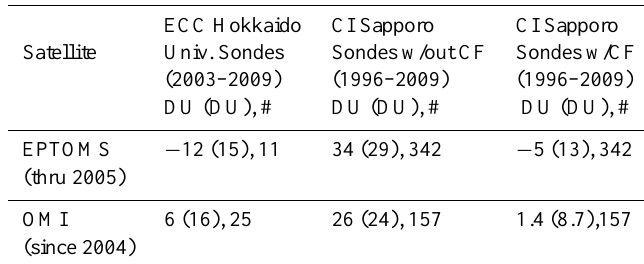
Table 9. Differences in column ozone amounts between ozonesondes and Earth Probe TOMS (EPTOMS) and Ozone Mapping Instrument (OMI). Data from electrochemical concentration cell (ECC) ozonesondes launched at Hokkaido University (which use the En-Sci two cell KI technology) and the Carbon Iodine (CI) ozonesondes launched at Sapporo both without and with correction factors (CF) applied. The data include the mean differences, 1 σ in parenthesis, and the number of flights compared after the